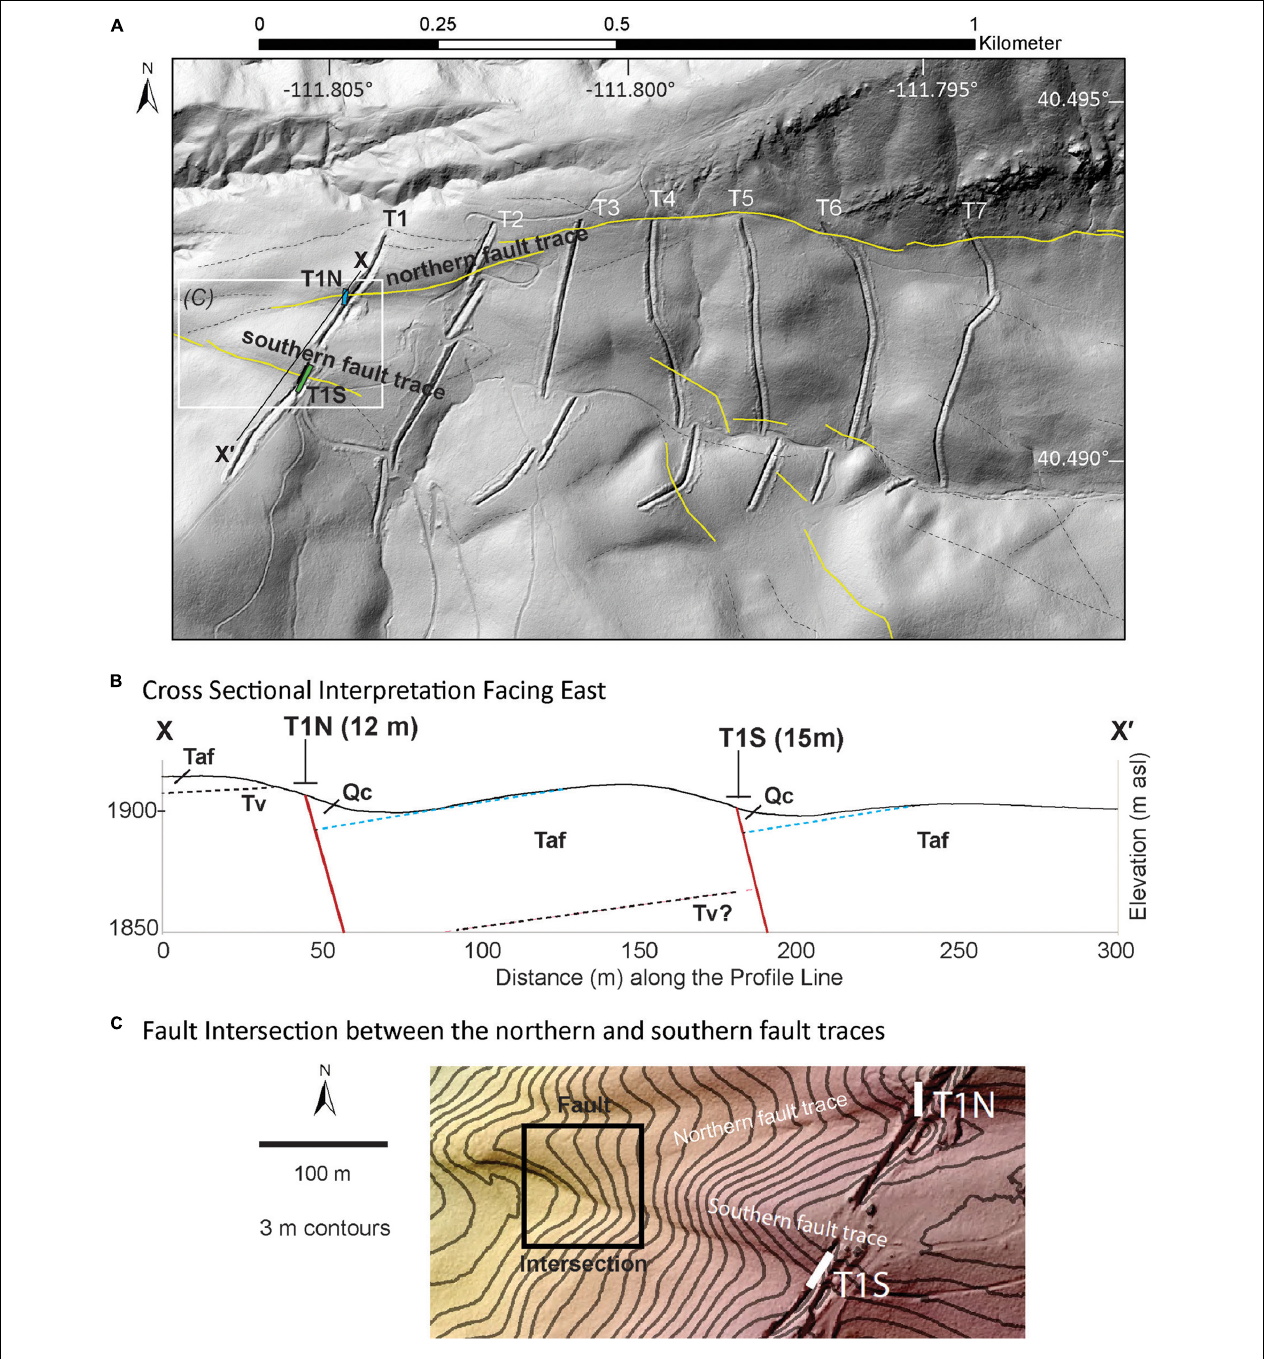
FIGURE 2 | (A) The Traverse Ridge site (TR site) consists of seven ∼ 500-m-long paleoseismic trenches (T1-T7) that were originally investigated as part of a geotechnical investigation for a now abandoned housing development. In this study, we reoccupied the westernmost trench (T1). We re-excavated two portions of T1, which crossed two prominent fault traces. Trench 1 north (T1N: small blue rectangle) was cut across the northern fault trace and reoriented, extending fault-perpendicular for about 14 m along a 170 ◦ trend from the existing trench at approximately 40.49254 ◦ , -111.80467 ◦ . Trench 1 south (T1S: small green rectangle) was exposed along the southern fault trace by widening the existing trench, which was already well oriented, perpendicular to the fault. Base map is a lidar-derived shaded relief map with a 315 ◦ illumination angle. Fault traces (yellow lines) and queried slope discontinuities (dashed black lines) are from Toké et al. (2017). (B) Topographic profile and cross-sectional interpretation from X to X (cid:48) . The northern and southern fault scarps cut through Tertiary volcanic (Tv) and alluvial fan (Taf) units (Biek, 2005). Quaternary colluvium (Qc) is observed on the hanging wall of the fault traces. The approximate locations and trench lengths are shown for T1N and T1S. (C) Three-meter contours overlain on a shaded relief map just to the west of the trench site. Here, it appears that the southern fault trace intersects and cuts the northern fault trace (within black box). This observation corresponds to trenching results that demonstrate a younger rupture in the T1S trench ( Figures 3 – 7